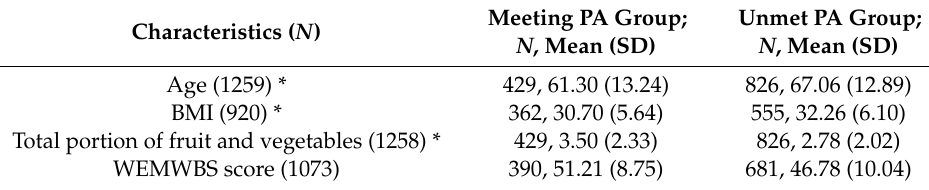
Table 2. Mean di ff erence of continuous variables among